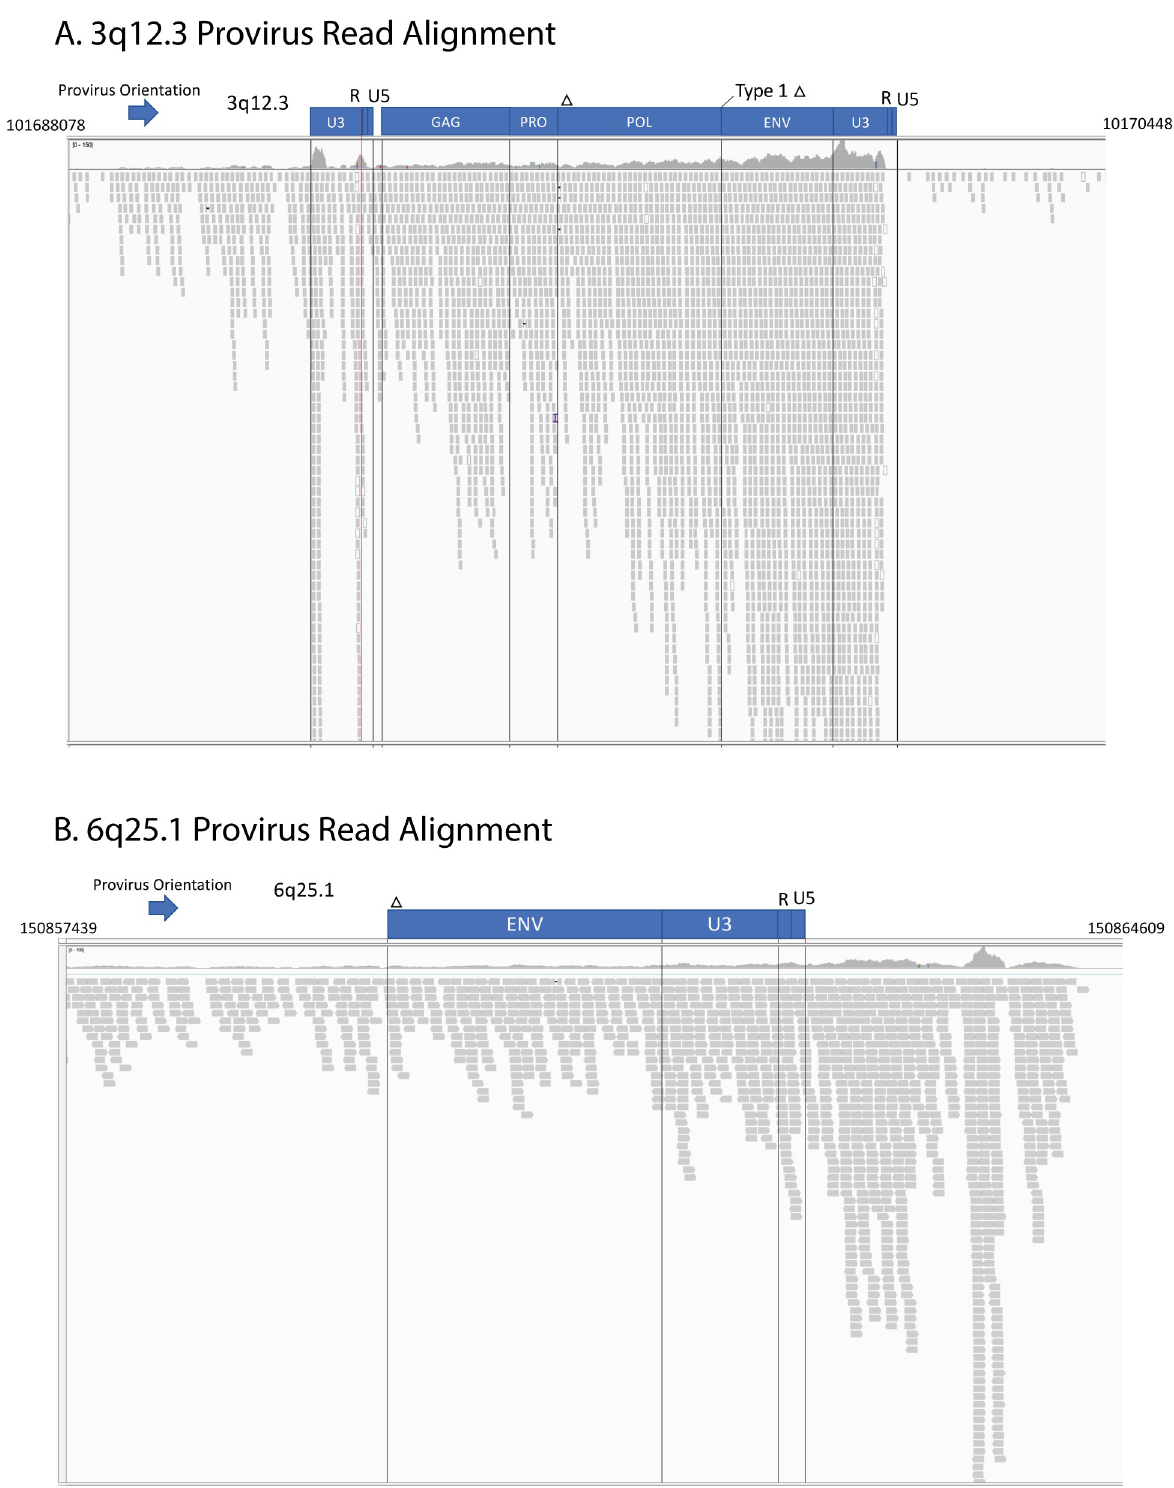
Fig 4. Expression of HML-2 proviruses can be self-driven or a result of the surrounding genomic neighborhood. These Integrated Gene Viewer snapshots show the alignment of GTEX RNA-seq reads to 2 proviruses. ( A ) 3q12.3. This representative alignment is from the cerebellum of 1 GTEx donor. The red line marks the location of the transcription start site. ( B ) Alignment of 6p25.1 from the spleen of another GTEX donor. Vertical lines demarcate divisions between the viral ORFs. Blue boxes denote provirus and gene structure. Genomic coordinates are displayed on the top left